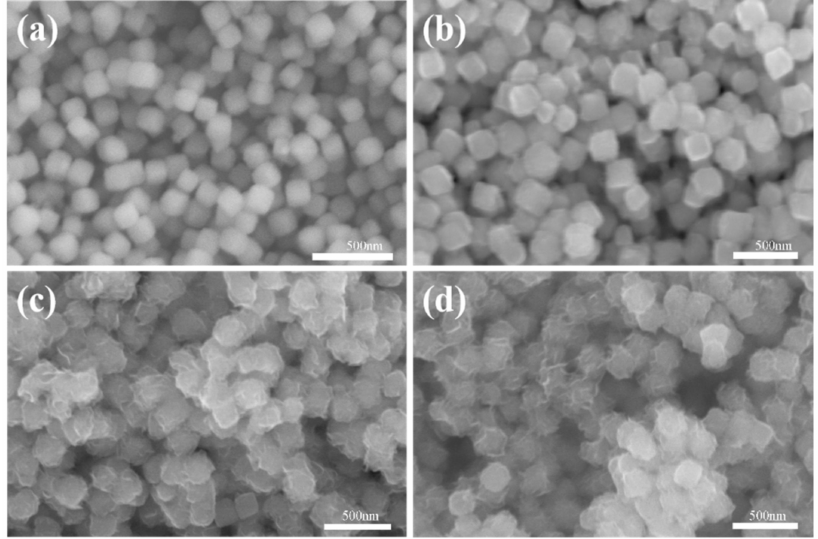
Figure 2. SEM images of Co 3 Sn 2 S x sample prepared with different mol content S element; ( a ) 0.4 mM S element; ( b ) 0.46 mM S element; ( c ) 0.5 mM S element; ( d ) 0.6 mM S